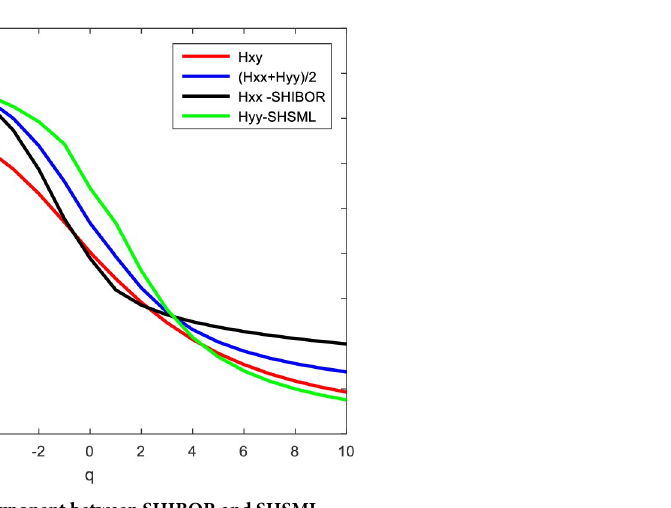
Fig 9. Long-term scaling exponent between SHIBOR and